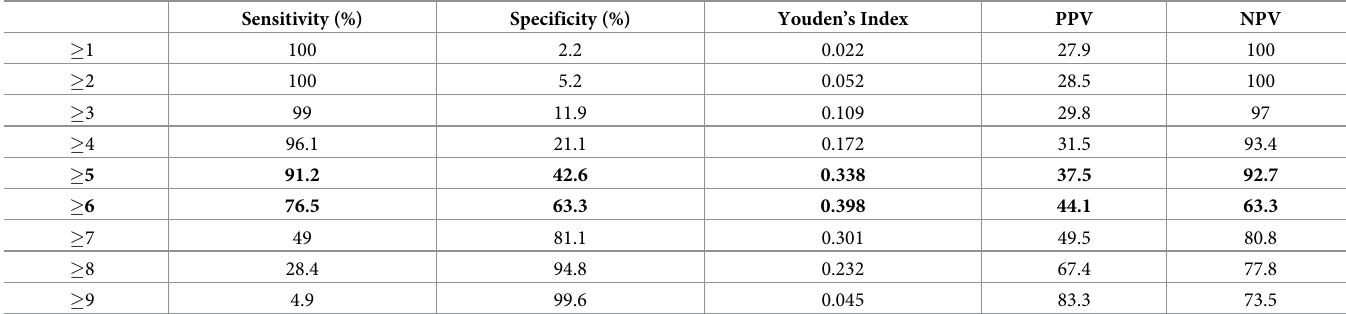
Table 4. Sensitivity, specificity, PPV, PNV for each cut-off point of the PUMA questionnaire.